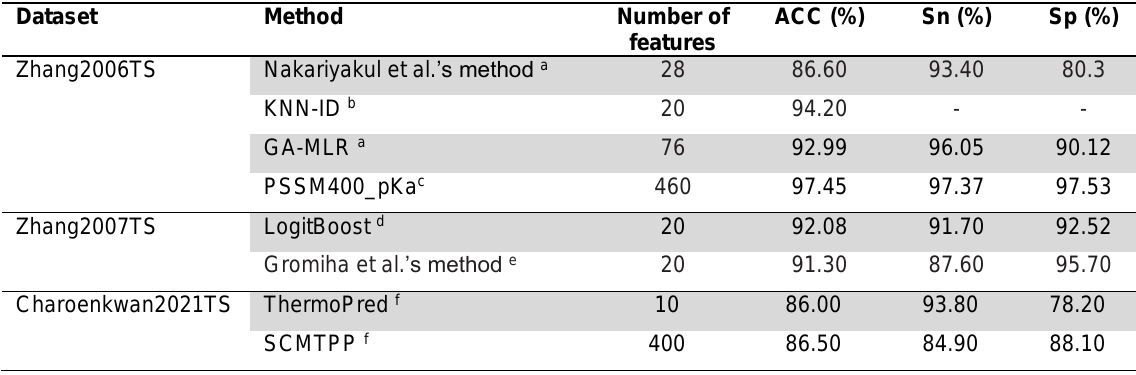
Table 5: Performance comparison of LogitBoost, Gromiha et al.’s method, ThermoPred and SCMTPP on three independent